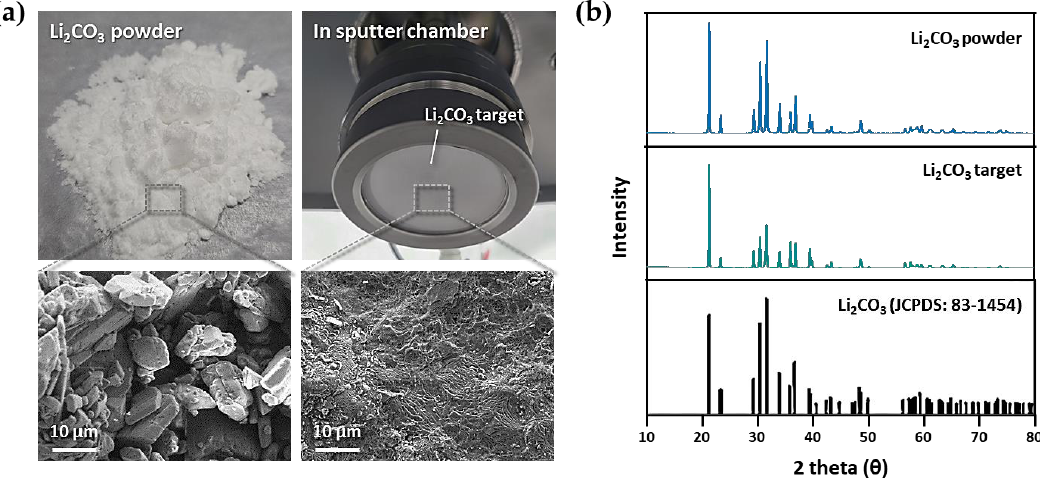
Figure 2. Analysis of the Li 2 CO 3 powder and Li 2 CO 3 sputter target. ( a ) SEM images of the surface microstructures of the Li 2 CO 3 powder and the Li 2 CO 3 sputter target. ( b ) XRD patterns of the Li 2 CO 3 powder and Li 2 CO 3 sputter